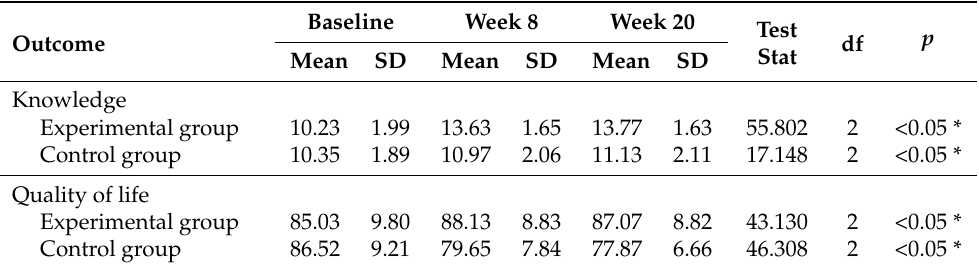
Table 4. Mean and standard deviation of knowledge and quality of life and comparison of knowledge and quality of life scores across time ( n = 30). Baseline Outcome